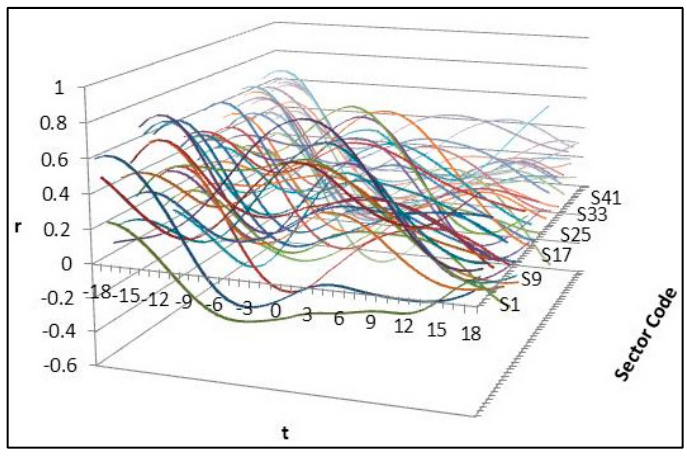
Figure 3. Correlation coefficient results of 46 sectors.